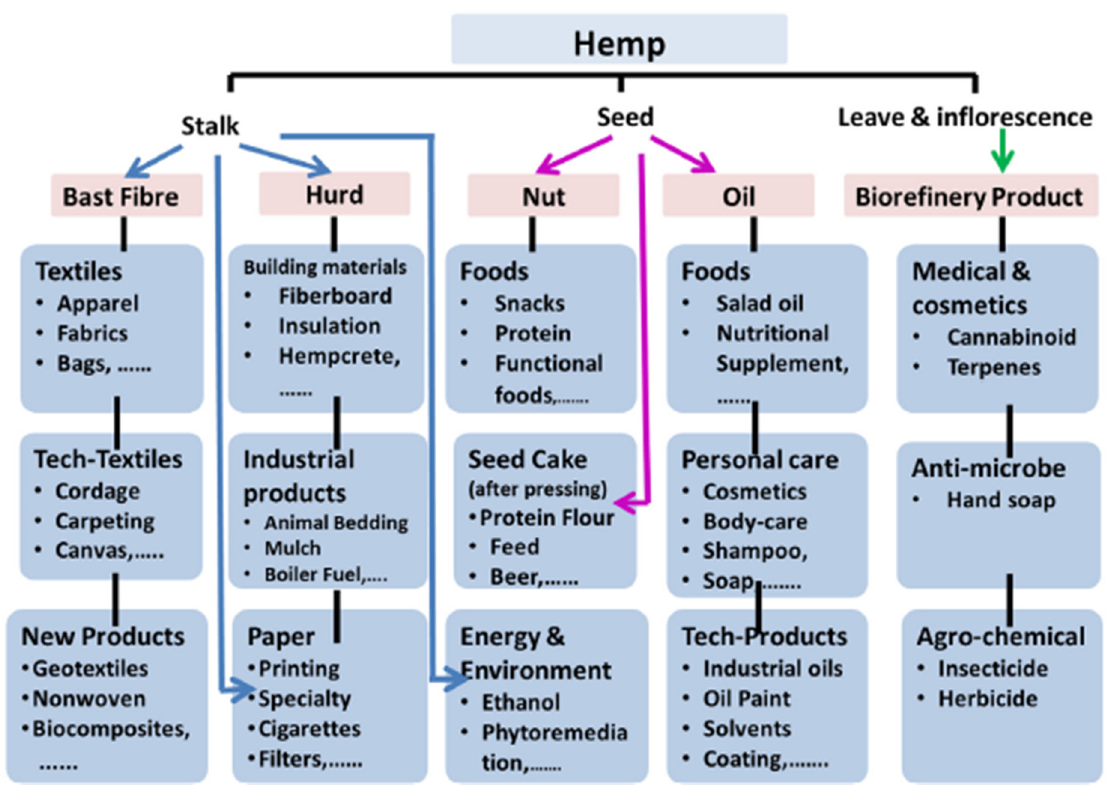
Figure 1. Flowchart of multi-purpose hemp utilization. Graphic is from Salentijn et al. [4].